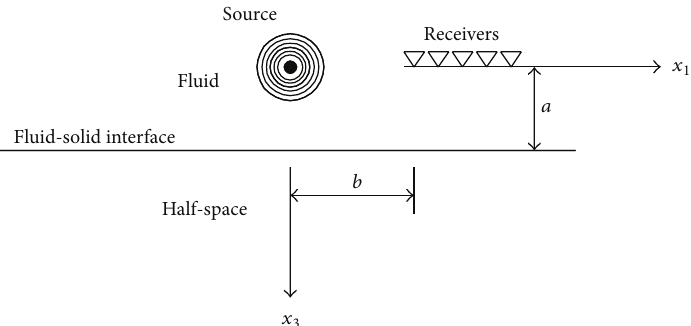
Figure 1: Fluid-solid interface solved by means of the DWN